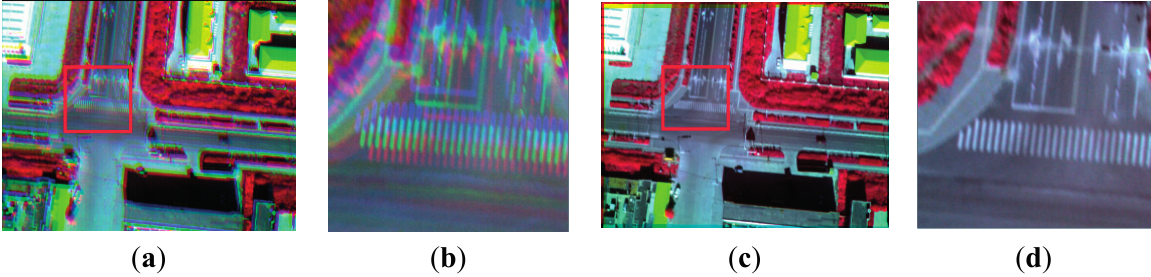
Figure 13. The CIR composite (infrared, red, green); ( a ) the unregistered multispectral image; ( b ) the enlarged partial region of ( a ); ( c ) the registered multispectral image; ( d ) the enlarged partial region of ( c ).